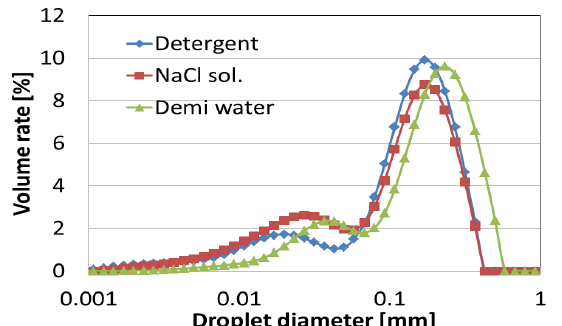
Fig. 8. A volumetric distribution of the droplets.